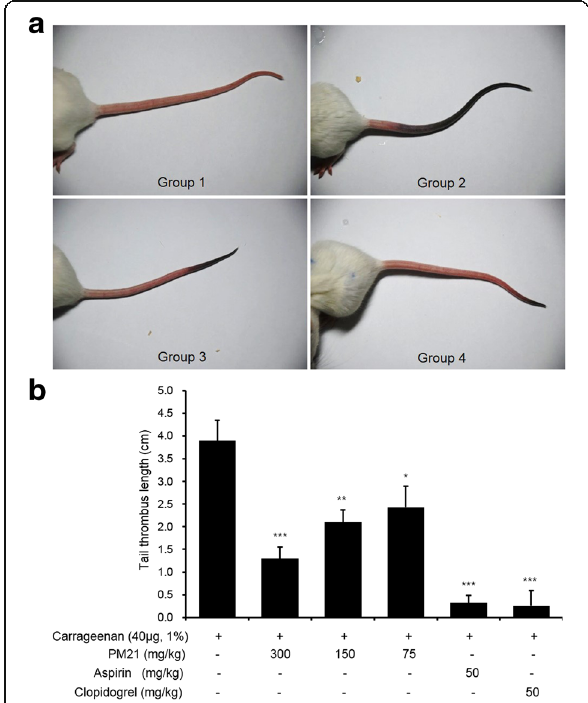
Fig. 7 a Effects of PM21 on carrageenan induced mouse tail thrombosis. Mouse tail thrombosis was induced by carrageenan. 40 μ L (1%) carrageenan (Type I) was administered by intraplantar injection in the right hind paw. PM21 (75 mg/kg, 150 mg/kg, 300 mg/kg), aspirin (50 mg/kg), clopidogrel (50 mg/kg), or vehicle was orally administered 1 h before the carrageenan injection, and thereafter treated with 24 h interval for 3 days. Mice were observed for the formation of thrombosis and photographed 1 h after the last treatment. Group 1 represents normal mouse. Group 2, group 3 and group 4 represent carrageenan treated vehicle, carrageenan plus PM21 (300 mg/kg), and carrageenan plus aspirin (50 mg/kg) treatments, respectively. b Effects of PM21 on carrageenan induced mouse tail thrombosis. Mouse tail thrombosis was induced by carrageenan. 40 μ L (1%) carrageenan (Type I) was administered by intraplantar injection in the right hind paw. PM21 (75 mg/kg, 150 mg/kg, 300 mg/kg), aspirin (50 mg/kg), clopidogrel (50 mg/kg), or vehicle was orally administered 1 h before the carrageenan injection, and thereafter treated with 24 h interval for 3 days. Mice were observed for the formation of thrombosis and thrombus lengths were measured 1 h after the last treatment. Data show the mean±SEM of six measurements. * p <0.05, ** p <0.01, *** p <0.001 versus vehicle control